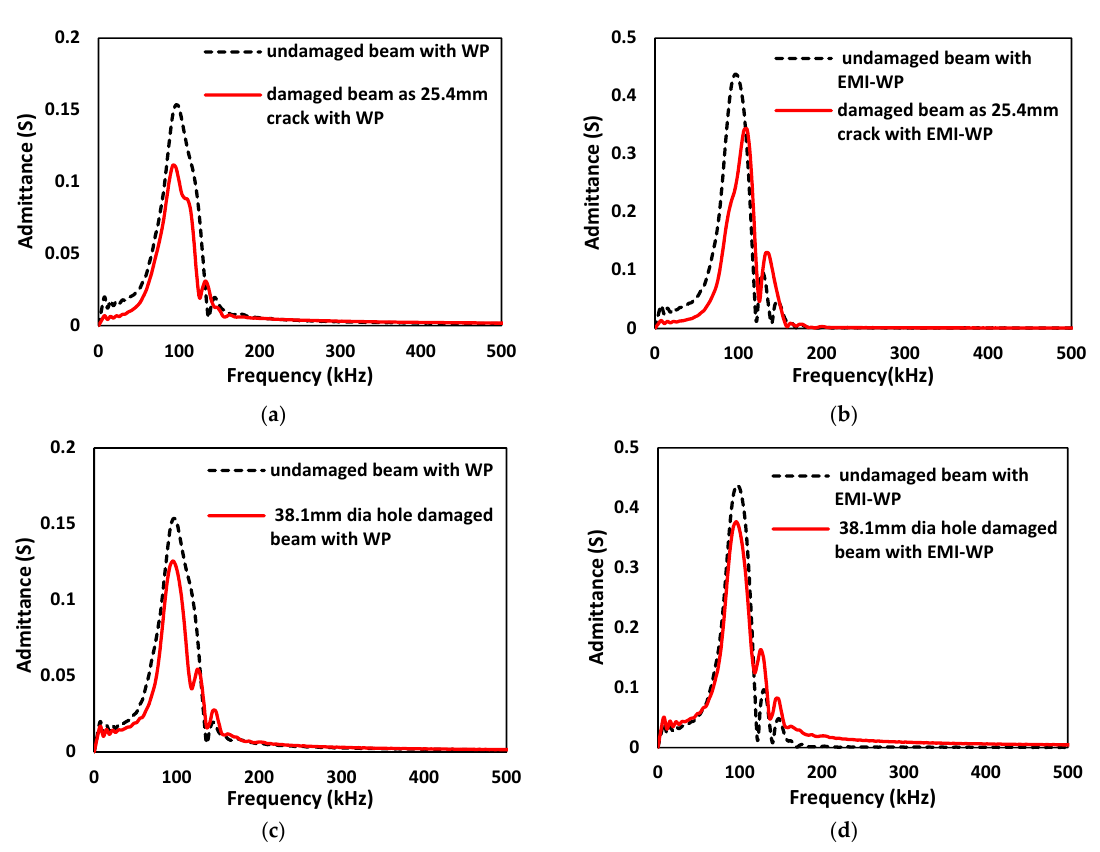
Figure 27. FFT Admittance spectrums for an undamaged and damaged concrete beam with: ( a , c ) active wave propagation; ( b , d ) when an EMI admittance sensor is activated simultaneously with wave propagation.